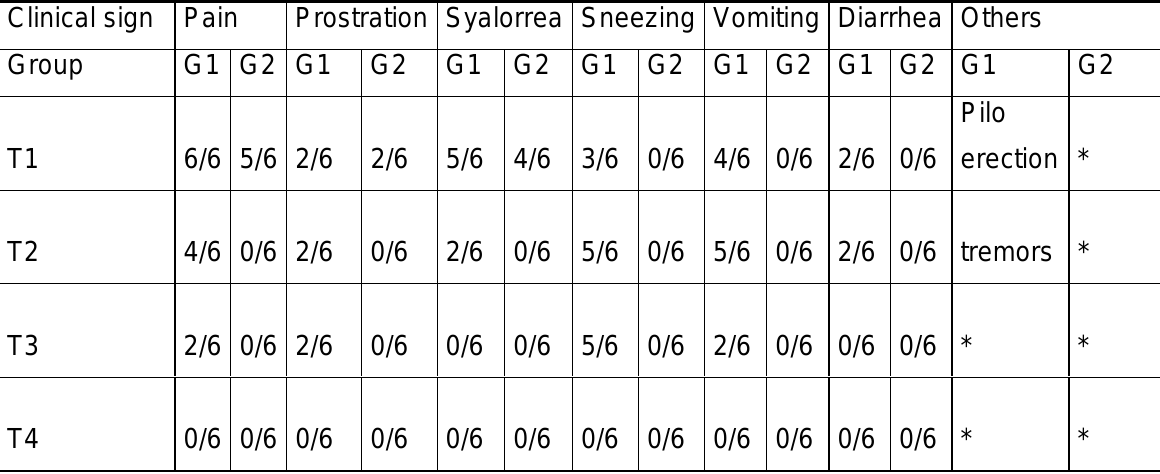
Table 2: Clinical signs in the two groups (6 animals each, G1 = 0.25 mg/kg and G2 = 0.4 mg/animal) studied at different moments (T1 = 1h after envenomation; T2 = 6h